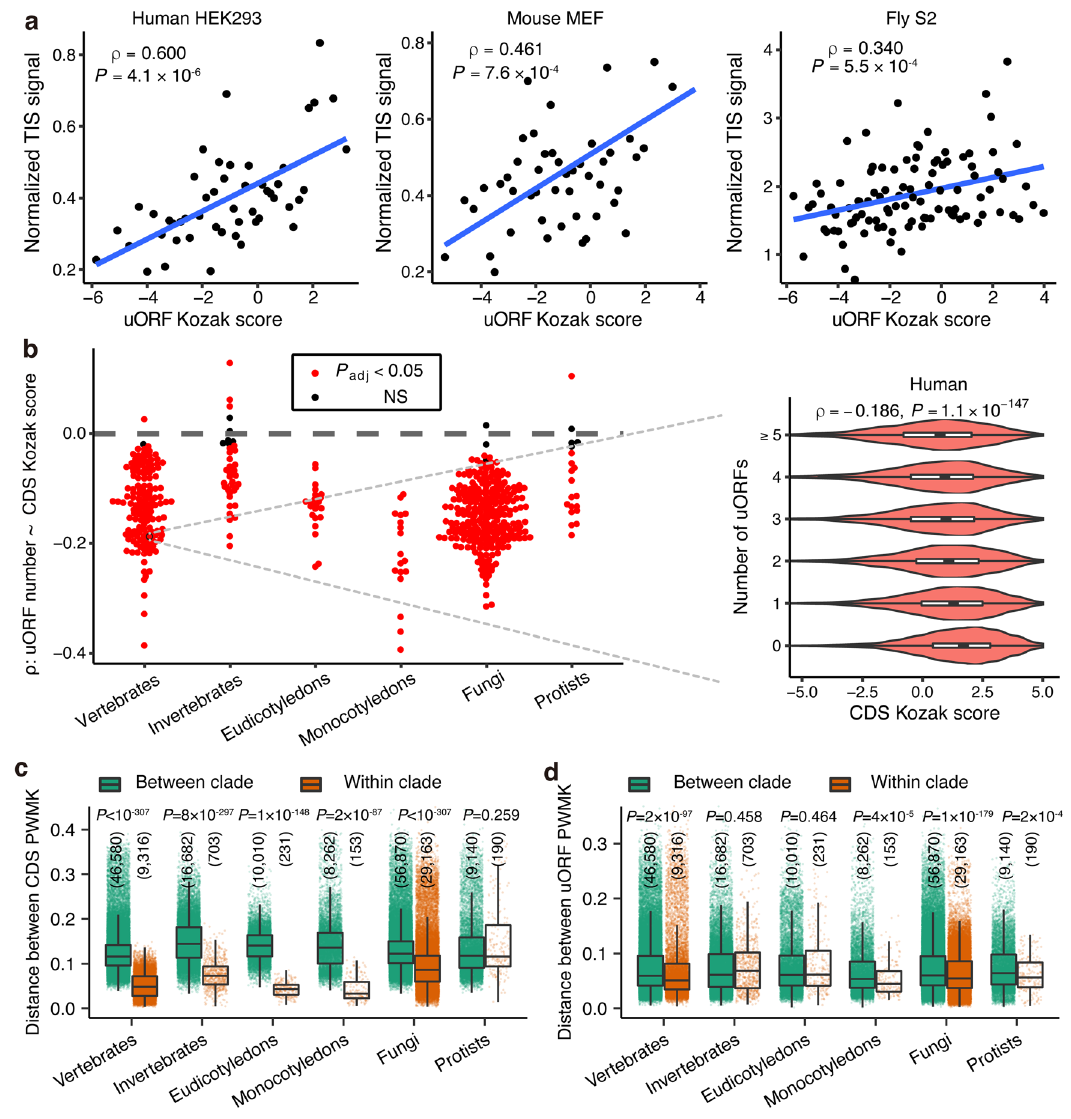
Fig. 6 The Kozak sequence contextual characteristics that in fl uence upstream open reading frame (uORF) translation. a Relationship between the Kozak scores and normalized translational initiation signals of uORF start codons (uoAUGs) in human HEK293 cells, mouse MEF cells, and fl y S2 cells. In each sample, we ranked uORFs based on increasing Kozak scores and divided them into 50 bins (100 bins for S2 cells) with equal numbers of uoAUGs. The median Kozak score and normalized TIS signal for each bin were used to calculate Spearman ’ s correlations ( ρ ) and two-sided P values. The linear fi t was indicated with a blue line. b The distribution of Spearman ’ s correlation coef fi cients between the coding sequence (CDS) Kozak scores and the number of uORFs for that gene in eukaryotes in different taxa. In the left panel, each dot represents one species. The right panel shows that in humans, genes that have multiple uORFs tend to have weaker Kozak sequence context around the start codon of CDSs. P adj , two-sided P value after correction for multiple testing; NS, not signi fi cant. Box plots showing the distribution of the Euclidian distance of the position weight matrix of Kozak sequences (PWMK) for cAUGs ( c ) and uoAUGs ( d ) between species within the same taxa (brown) or species in different taxa (green). Differences in distances were compared with two-sided Wilcoxon rank-sum tests. Exact P values (no correction for multiple testing were made) and the number of pairwise distances in each group were shown in the plot. Center line, median; box limits, upper and lower quartiles; whiskers, 1.5 times the interquartile range. Source data are provided as a Source Data fi